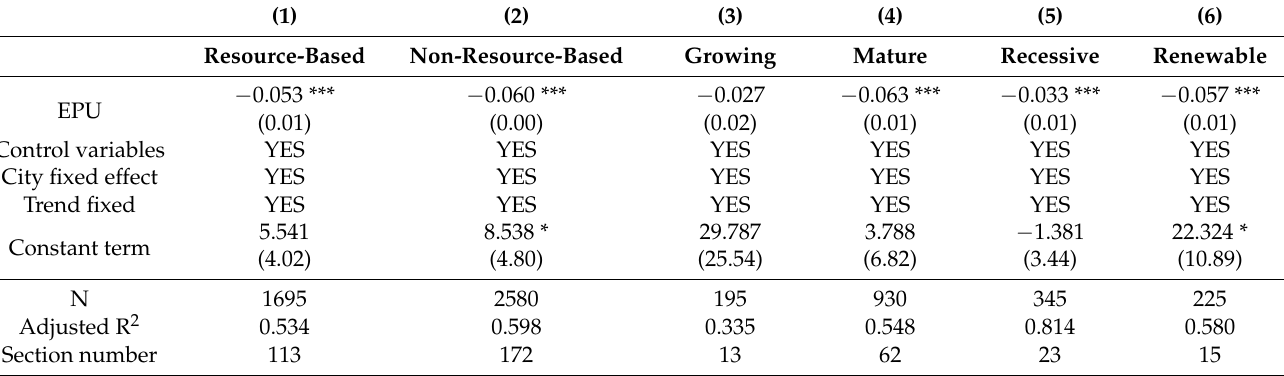
Table 8. Resource-based city (different development stages).